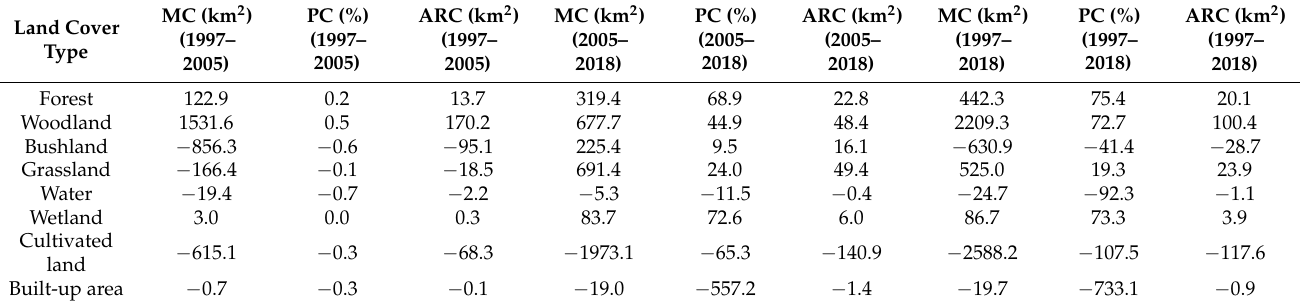
Table 7. The magnitude of change, percentage of change, and the annual rate of change for land cover classes in the Singida